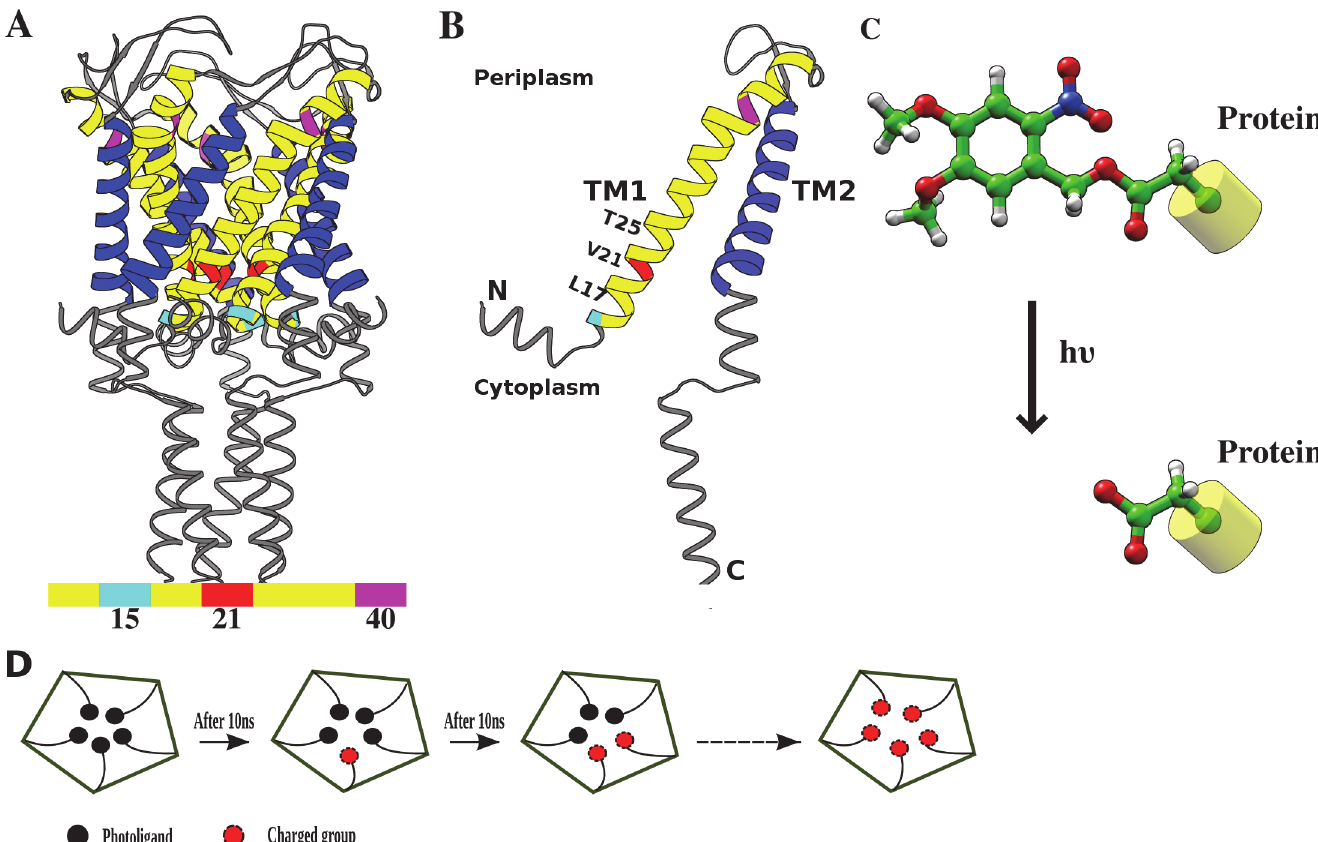
Fig 1. Structure of Tb-MscL and photo-sensitive compound. (A) X-ray crystallographic structure of Tb-MscL (PDB ID: 2OAR) with the transmembrane helices TM1 and TM2 colored in yellow and blue, respectively. Locations of residues lining the inner helix (TM1) are indicated. (B) Single subunit of Tb-MscL. (C) Structure of photo-sensitive compound that releases the charged group upon light irradiation. (D) Schematic view of the step-by-step substitution process followed in the MD simulation